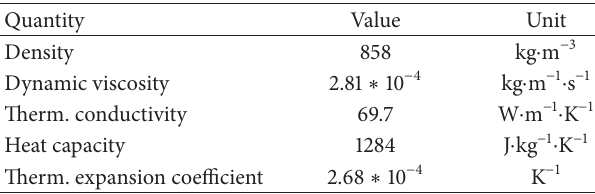
Table 1: Parameters for the pressure loss correlation. Direction 𝑎 𝑏 𝑈 𝐷 Axial 0.316 0.25 Transverse 4.03 0.27 Table 2: Physical properties of sodium at 400 ∘ C. Quantity Value Unit Density 858 kg ⋅ m − 3 Dynamic viscosity Therm.